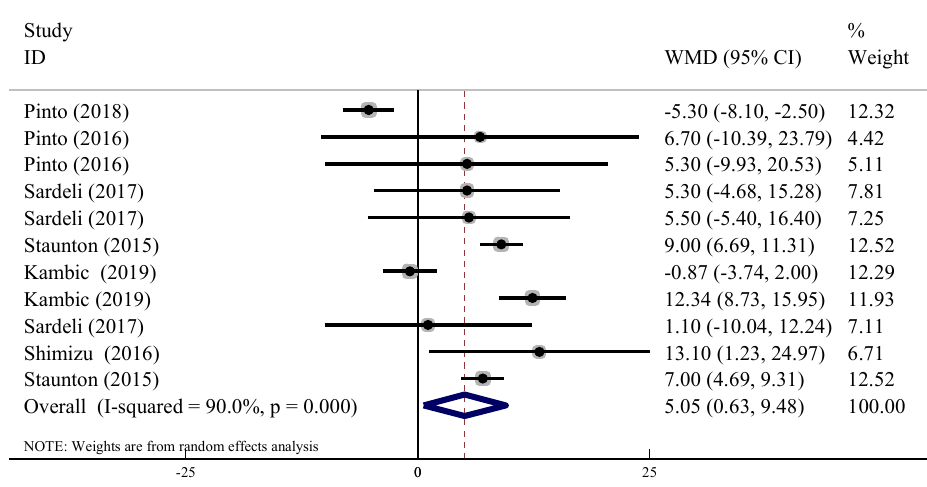
Figure 4. Forest plot of the acute effect of BFR-LI training on SBP.